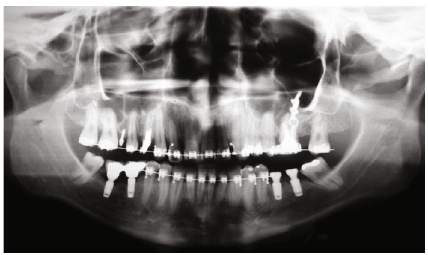
Figure 6: Progress panoramic